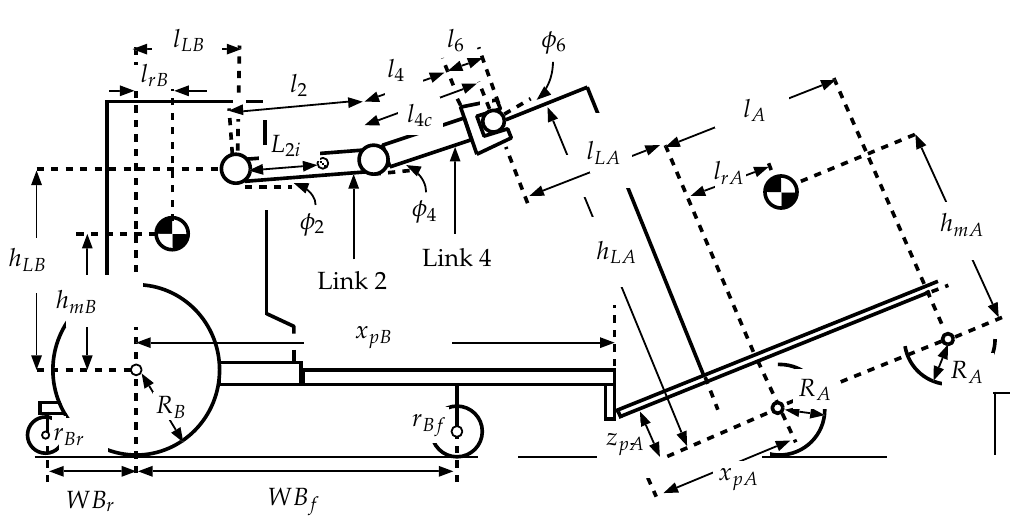
Figure 3. Model of the robot and the hand cart.